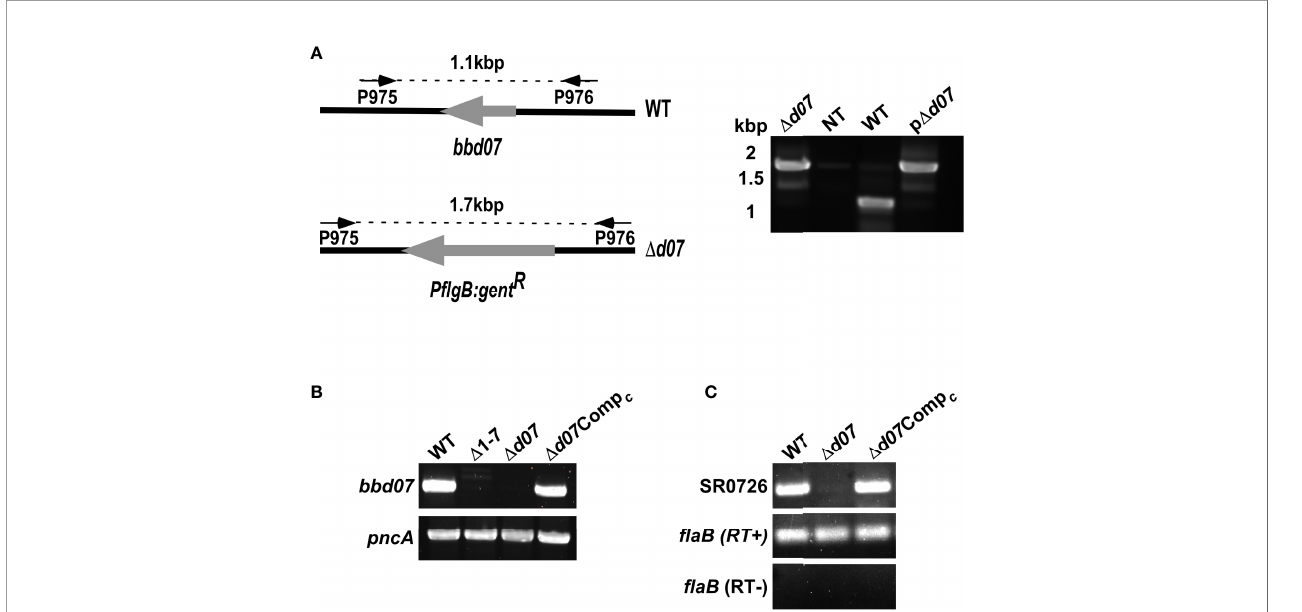
FIGURE 4 | Targeted deletion of bbd07 . (A) Schematic illustrating the relevant segment of lp17 in the wild type (WT) and the bbd07 knockout ( D d07 ). Screening primer annealing sites and expected amplicon lengths are shown above each schematic with arrows connected by dashed lines. (B) PCR con fi rmations of presence or absence of SR0726 genetic region. (C) Veri fi cation of presence or absence of SR0726 transcription in indicated strains by RT-PCR using